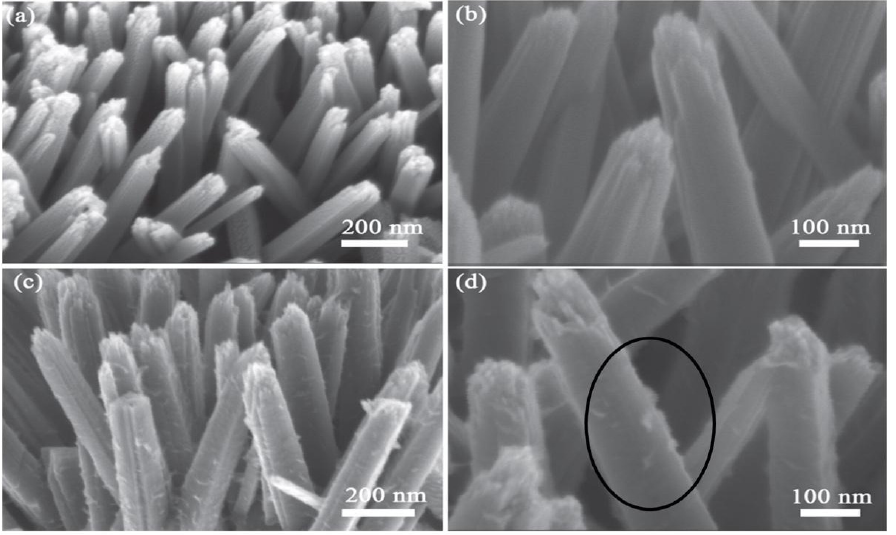
Figure 19. SEM images of ( a , b ) pure rutile TiO 2 nanotube arrays, ( c , d ) GQD-deposited rutile TiO 2 nanotube arrays. Figure 19 Reprinted with permission from [86]. Copyright 2016 IOP Science.